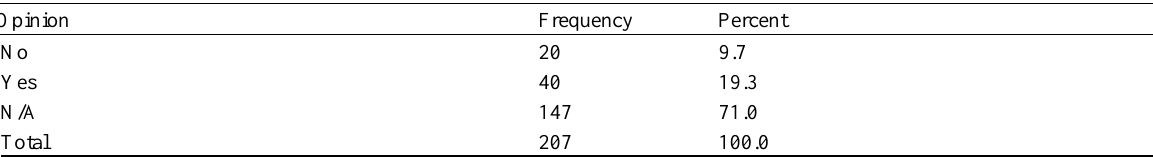
Table 16: Community are involved in Reporting and Feedback